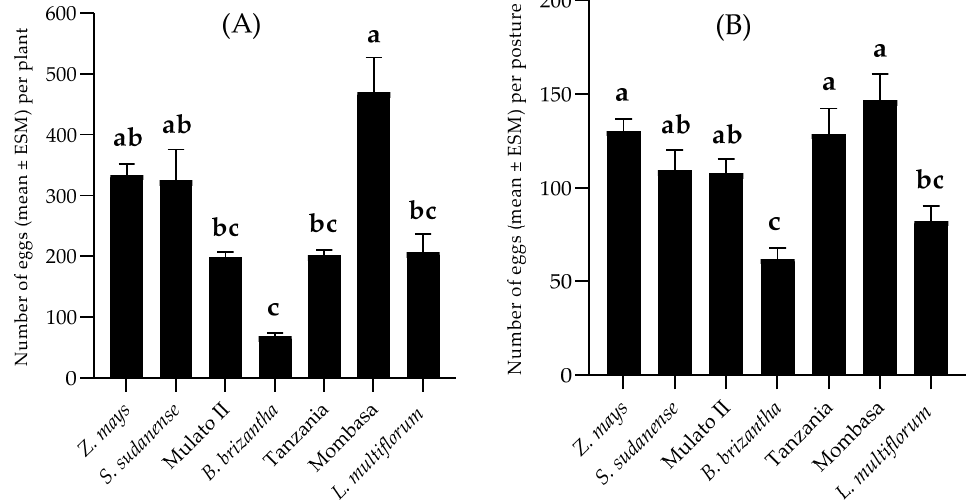
Figure 3. Number of eggs (Mean ± SEM) oviposited per plant ( A ) and per posture ( B ) by S. frugiperda in no-choice test. Different letters atop the bars indicate significant differences (Tukey test, α = 0.05).